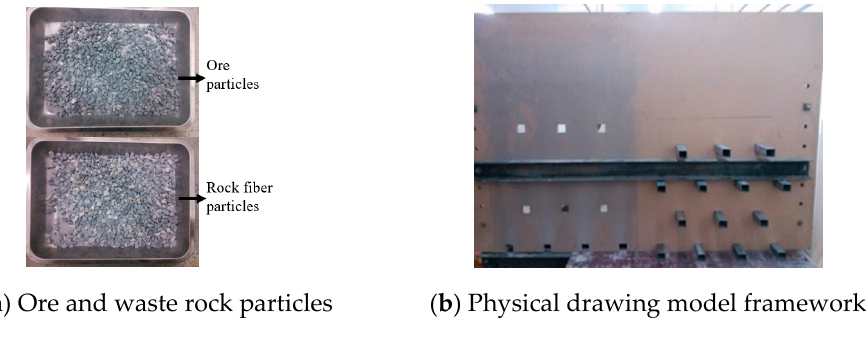
Figure 15. Drawing process diagram ( a ) before drawing, ( b ) at the initial drawing stage, ( c ) at the middle drawing stage, and ( d ) at the end of ore drawing.